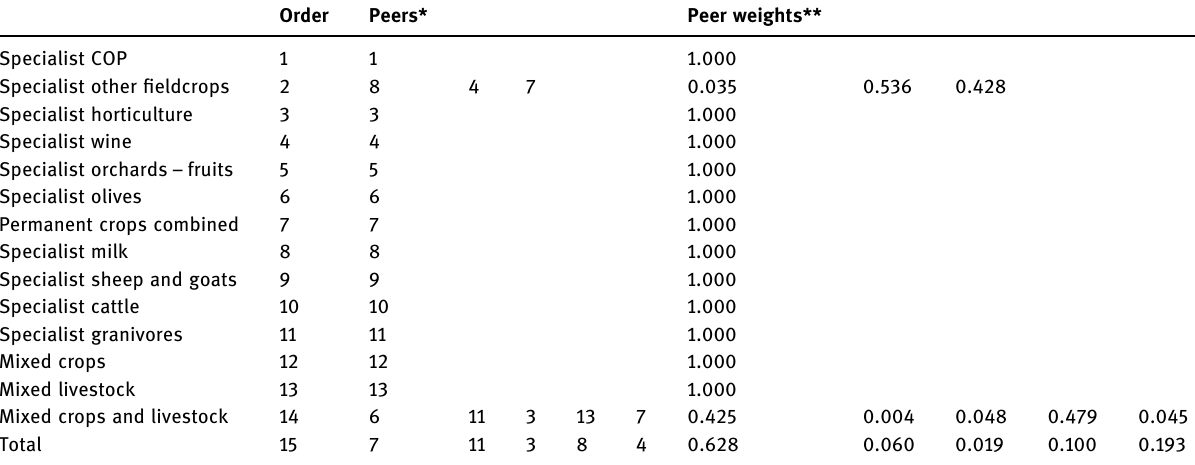
Table 4: Peer and peer weights ( obtained through input orientated DEA and using multi - stage method ) for the several EU farm types ( data on average for the period 2014 – 2018